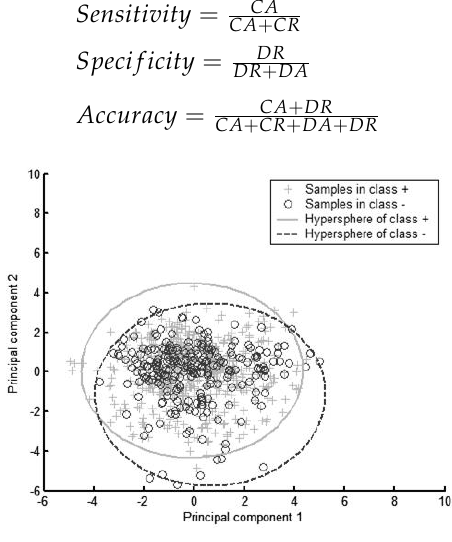
Figure 2. Principal components plot of SVDD for German data set.